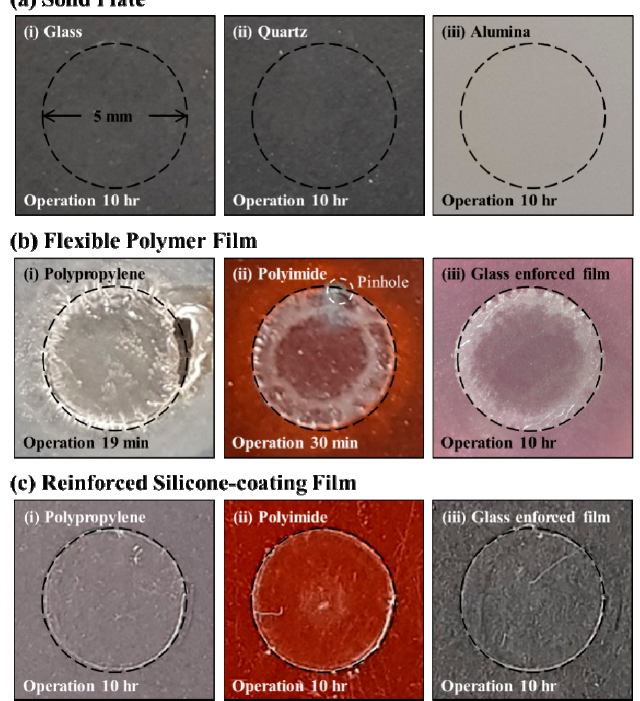
Figure 8. Surface pictures of the solid plates after the extended-run operation ( a ), the flexible polymer films ( b ), and the reinforced-silicone (Si)-coating films ( c ) after the 10-h operation at the current of approximately 3 mA.